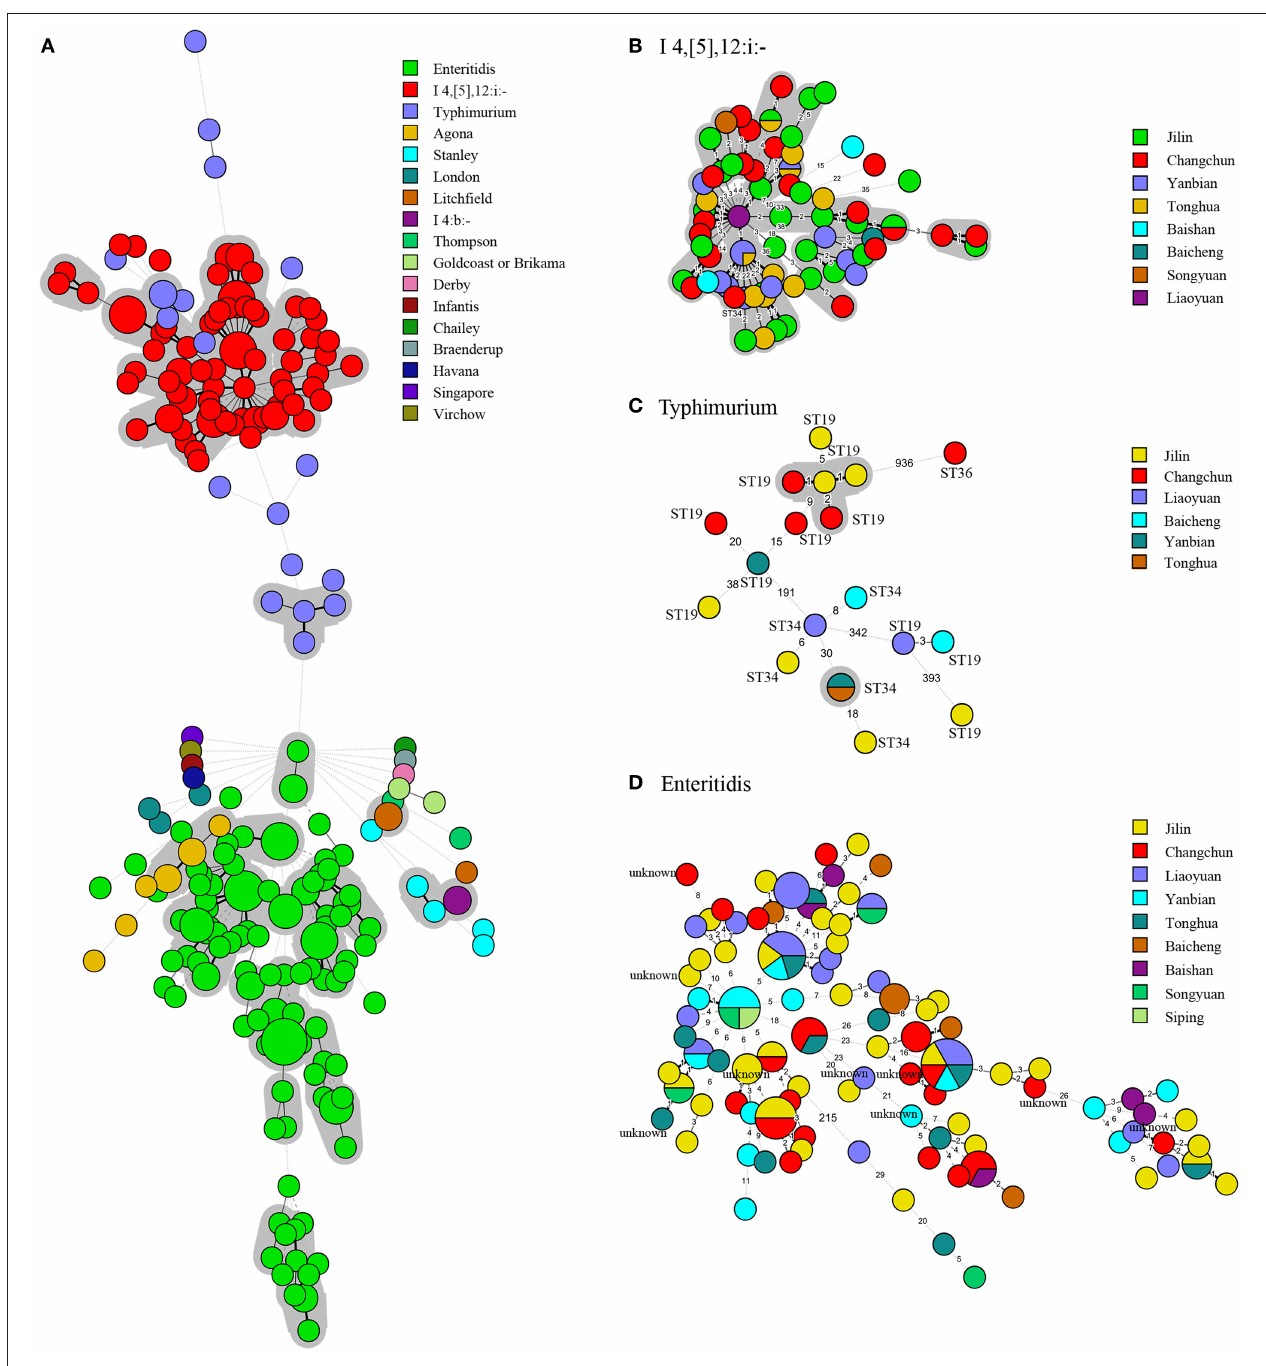
FIGURE 2 | Minimum spanning tree of core genome MLST for 260 Salmonella strains. Every strain was filled with different colors according to its serotypes. Allele distances among B, C and D strains were labeled. The circle size represented the number of strains. (A) In total, 260 Salmonella strains MST based on core genome MLST (cgMLST). (B) The upper layers filled with red Salmonella strains showed the same STs of 34. (C) The middle scatter Salmonella strains with no serotype distribution law. (D) The lower layer filled with green Salmonella strains was all